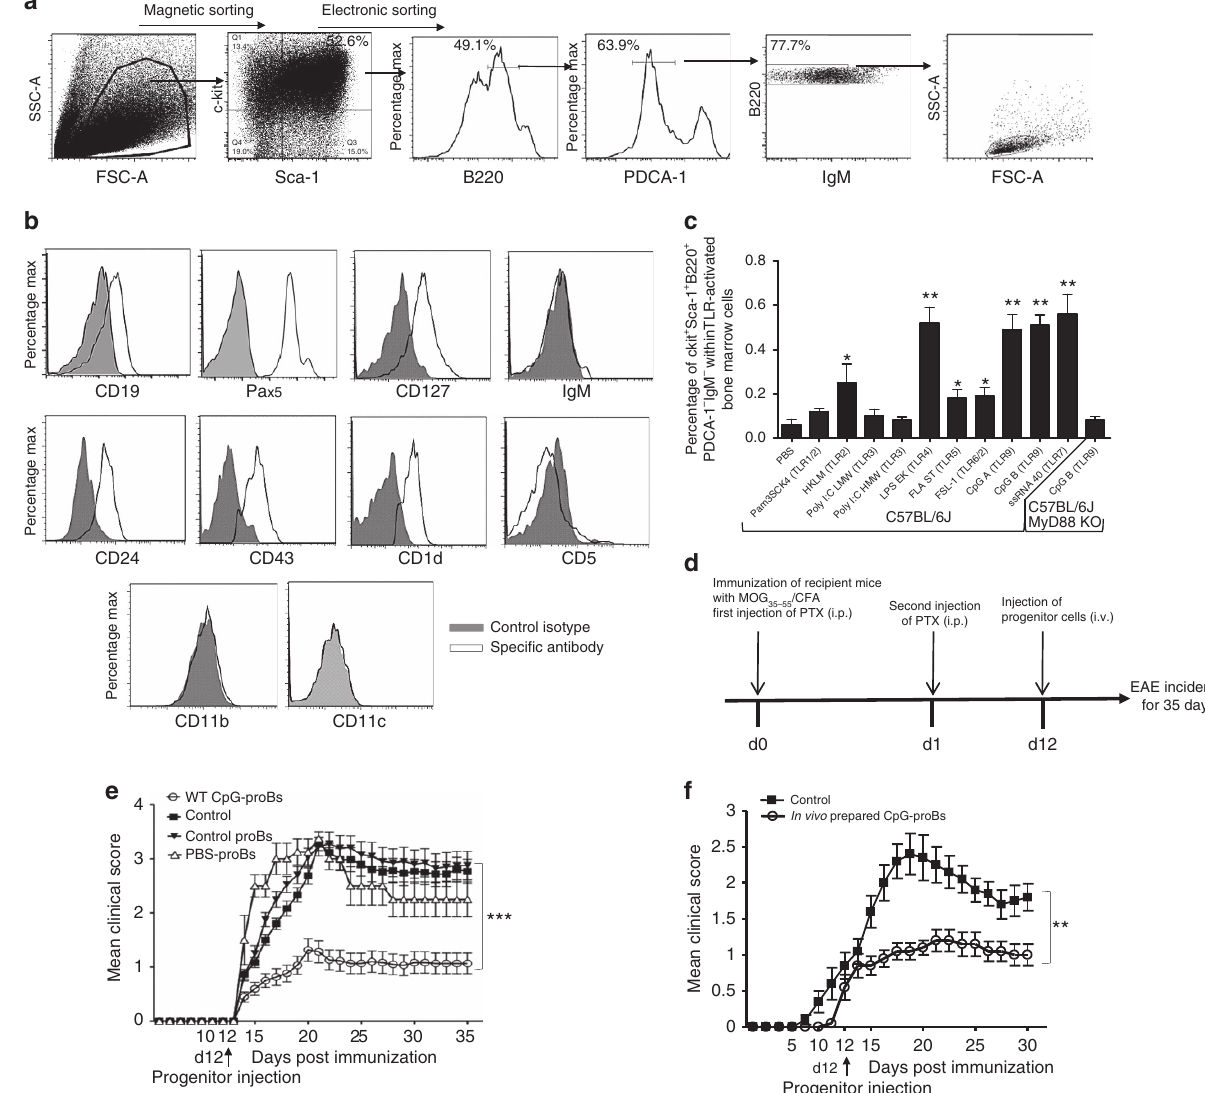
Figure 1 | Phenotypic analysis of CpG-induced c-kit þ Sca-1 þ B220 þ PDCA-1 (cid:2) IgM (cid:2) BM cells and assessment of disease protection against ongoing EAE. ( a ) BM cells incubated for 18h with CpG-B (1 m gml (cid:2) 1 ), were magnetically selected for c-kit þ cells, further labelled for Sca-1, B220, PDCA-1 and IgM and electronically sorted into small-size (FSC low SSC low ) c-kit þ Sca-1 þ B220 þ PDCA-1 (cid:2) IgM (cid:2) cells. ( b ) Flow cytometry analysis of indicated B-cell markers expression by CpG-proB cells after cell-sorting as in a . ( a , b ) Cells were stained with specific antibodies (open histograms) or isotype controls (filled histograms). ( c ) Frequency of c-kit þ Sca-1 þ B220 þ PDCA-1 (cid:2) IgM (cid:2) cells emerging among BM cells after 18h of incubation with different TLR agonists. CpG-B was tested in BM cell cultures of both WT and MyD88 (cid:2) / (cid:2) C57BL/6J mice. Results are expressed as means ± s.e.m. from three experiments. * P o 0.05, ** P o 0.005 when comparing stimulated and unstimulated BM cells, using non-parametric Mann–Whitney’s t -test. ( d ) Experimental protocol for MOG 35–55 EAE disease induction and intravenous progenitor cell transfer (60,000 cells per mouse) at day 12 post-immunization. ( e , f ) EAE clinical scores (mean ± s.e.m.) over 35 days of the indicated groups of mice. ( e ) n ¼ 30 mice per group, except for PBS-ProB-recipient group in which n ¼ 4 mice.